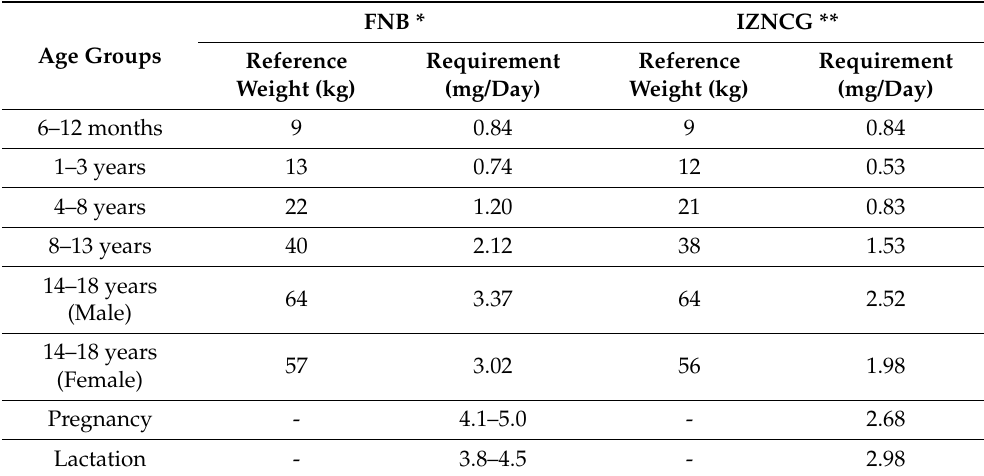
Table 1. Average requirements of zinc.